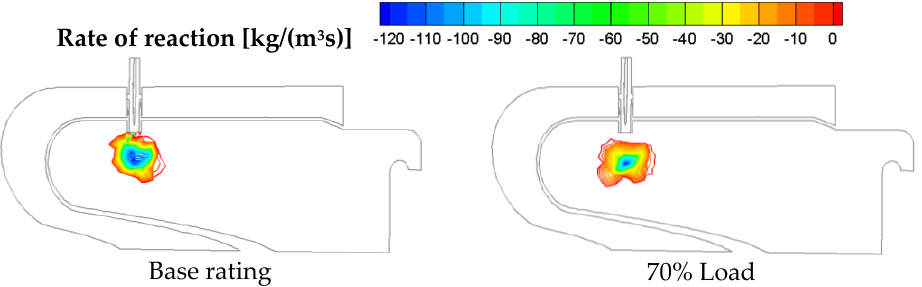
Figure 5. Methane reaction rates at full load and partial load [36].